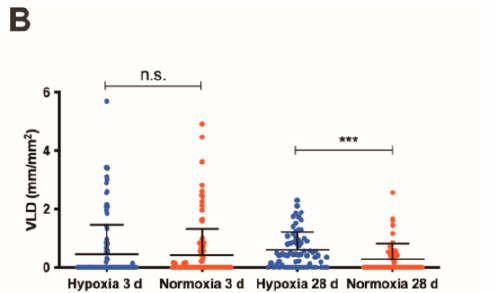
Figure 5. In vivo vascularization potential of SVF-based patches. ( A ) Immunofluorescence staining endothelial cells (Ve-caderin, red), human nuclei specific marker (HuNu, green) of constructs generated by SVF cells in severe hypoxia and normoxia perfusion-based culture with investigation time points 3 and 28 days (d) at low (20×) and high (40×) magnifications (scale bars = 50 µm and 25 µm, respectively). ( B ) Quantification of vessel length density (VLD) of constructs cultured under severe hypoxia or in vitro normoxia after implantation in vivo with investigation time points 3 and 28 days. *** p < 0.001; n.s. = not statistically significant. Comparison was performed with one-way ANOVA. Number of donors: 3 donors (at least duplicate biological samples per donor).